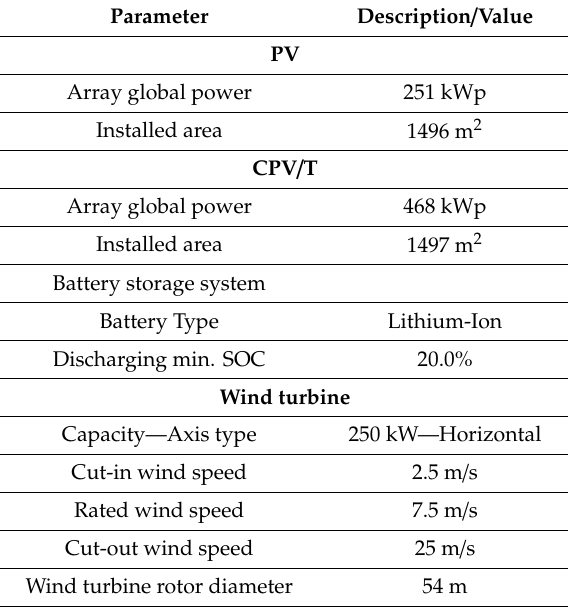
Table 2. Main components’ technical